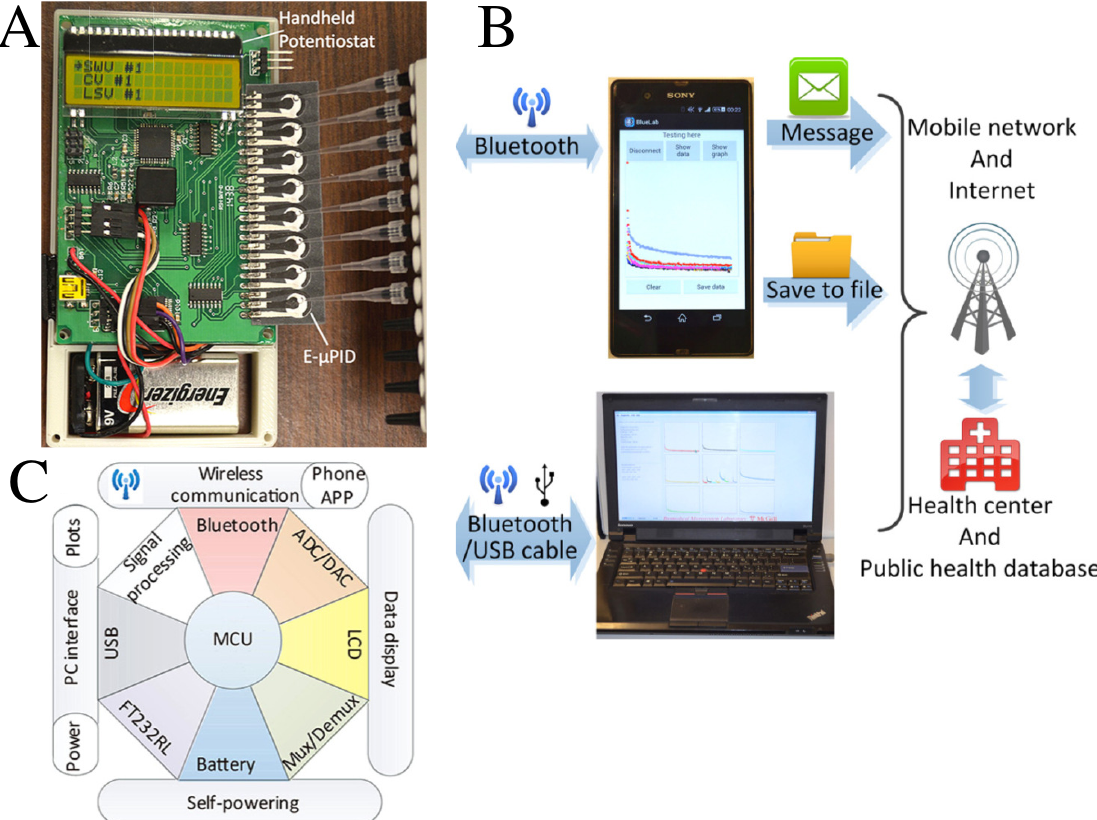
Figure 8. ( A ) Photograph and ( B ) architecture of a handheld potentiostat integrated with a paper-based microfluidic device for wireless communication of results to a smartphone or a computer application. ( C ) Illustrative representation of the communication of sensing results to the Internet or a health center for further processing. Adapted with permission from Ref. [85]. Copyright 2016 AIP